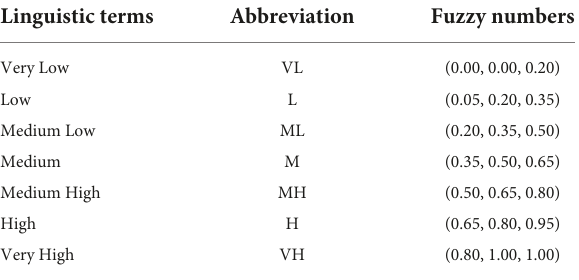
TABLE 1 Fuzzy linguistic variables for weights of various attributes.